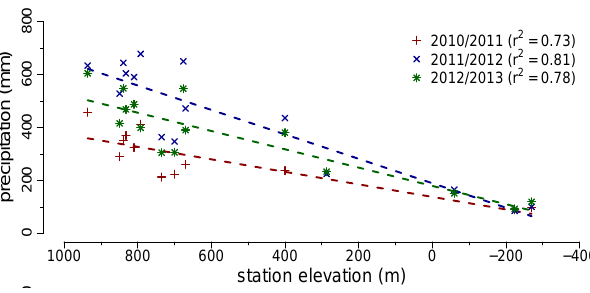
Figure 3. Correlation between average annual rainfall and station elevation for the individual hydrological years during the observa- tion period 2010–2013.